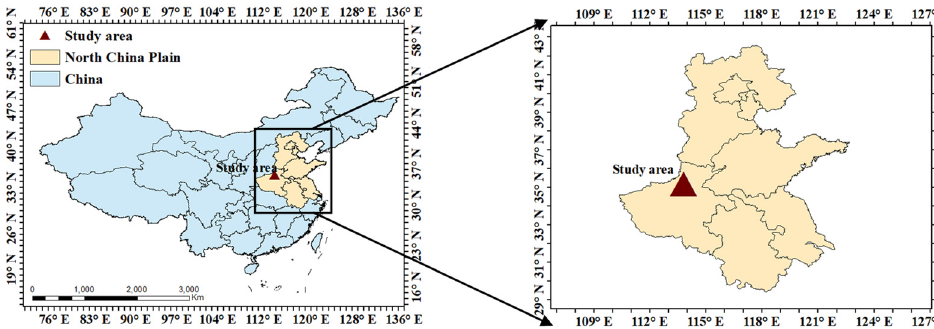
Figure 1. Location of the study area.